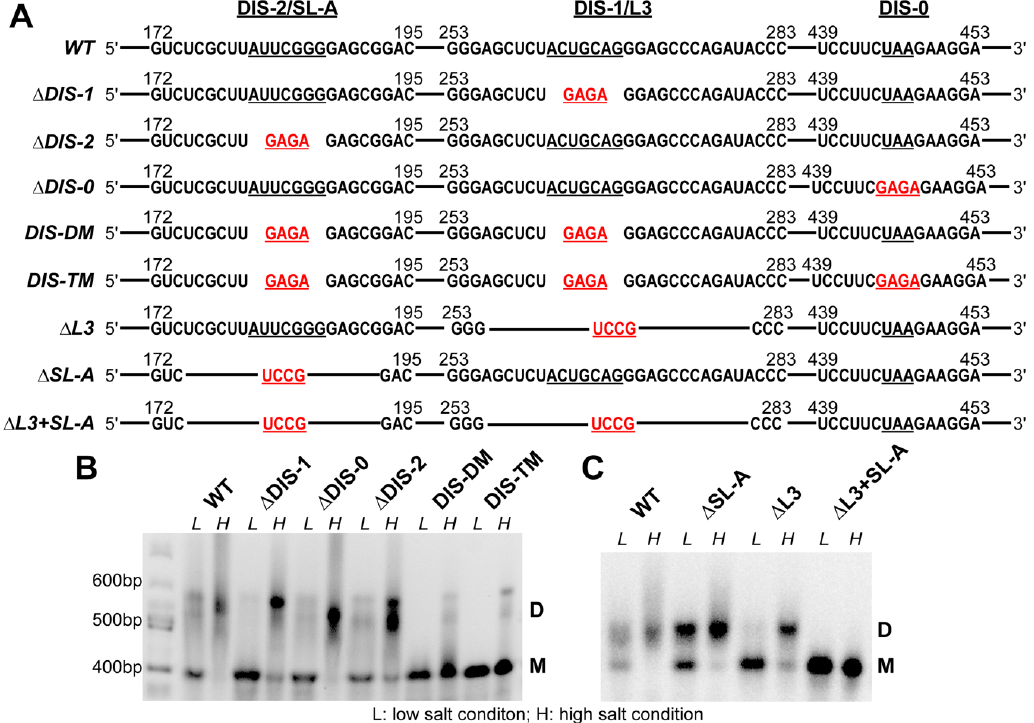
Figure 2. ( A ) RNA constructs used in the dimerization studies. Sequences in the regions containing DIS-2 / SL-A, DIS-1 / L3 and DIS-0 are shown. Nucleotides in the loop regions are underlined. Tetraloop mutations are highlighted in red. ( B ) Native agarose gel showing the results of dimerization assays of the wild-type (WT) RSV 5 (cid:48) -leader and dimerization initiation signal (DIS) loop mutants. RNAs (0.5 µ M) were folded under low salt (L) or under high salt (H), as described in the Materials and Methods. Locations for monomeric (M) and dimeric RNA bands (D) are indicated. This gel shown is representative of three independent replicates. ( C ) Native agarose gel showing the results of dimerization assays of the WT RSV 5 (cid:48) -leader and more extensive stem loop deletion mutants. The conditions are the same as panel (B). This gel shown is representative of two independent